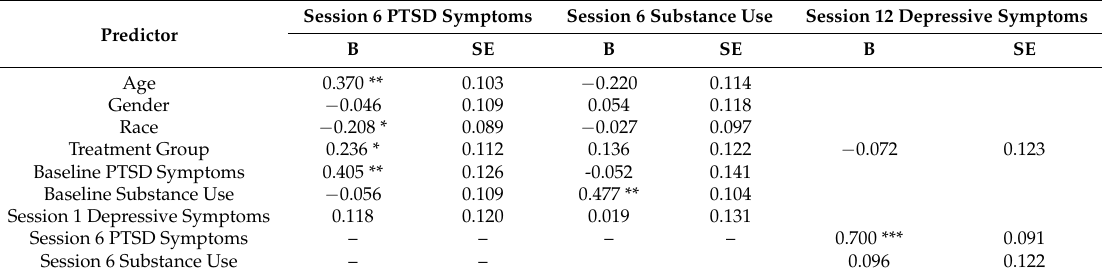
Table 2. Standardized model results.